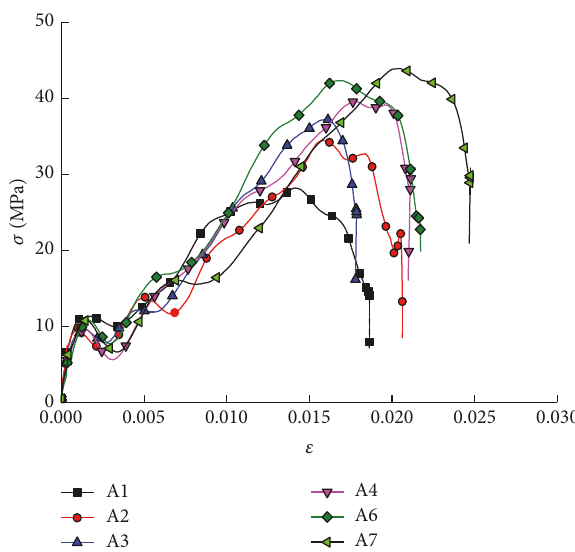
Figure 8: Stress-strain curves of coal-rock combined bodies under different loading rates.